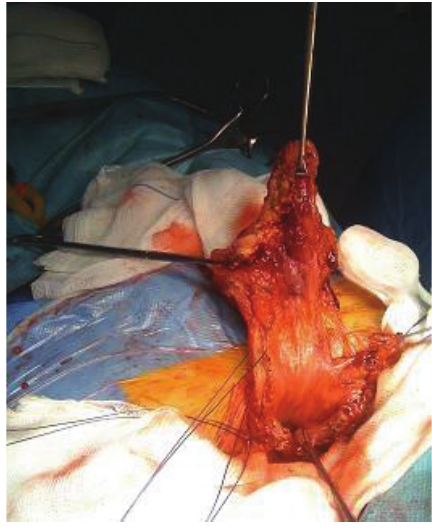
Figure 2: An intraoperative view of the herniated portion of the